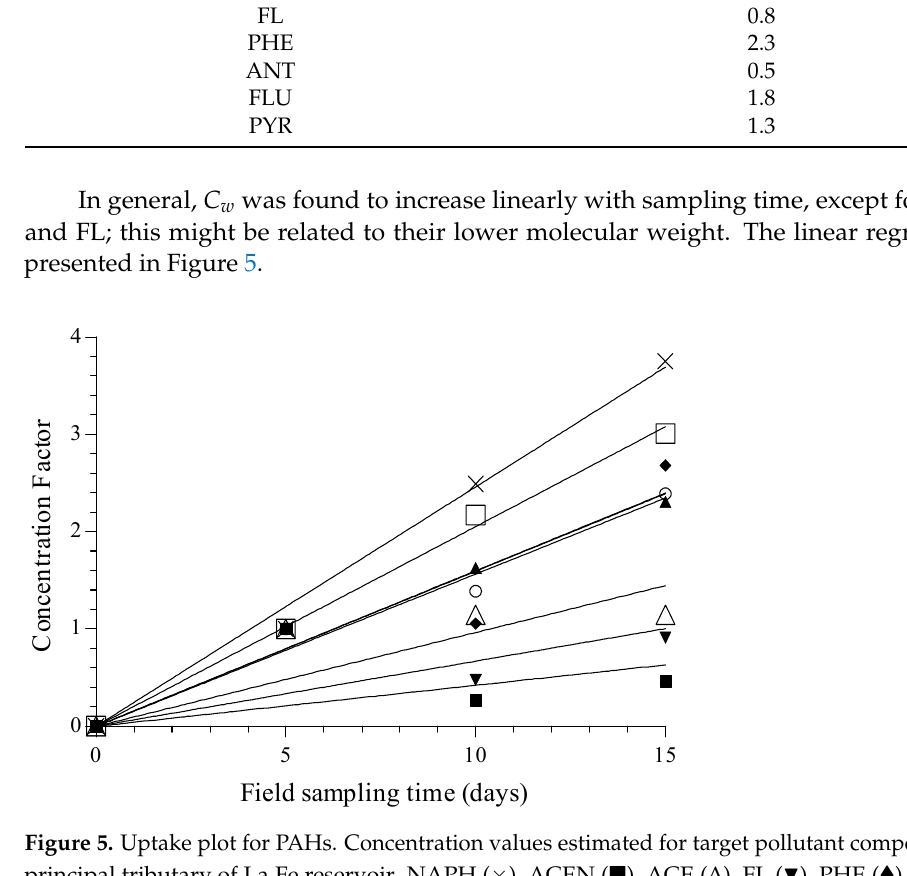
Table 3. The C w estimated for each PAH congener after 5 days of SPMDs’ exposure in the water body of the reservoir.